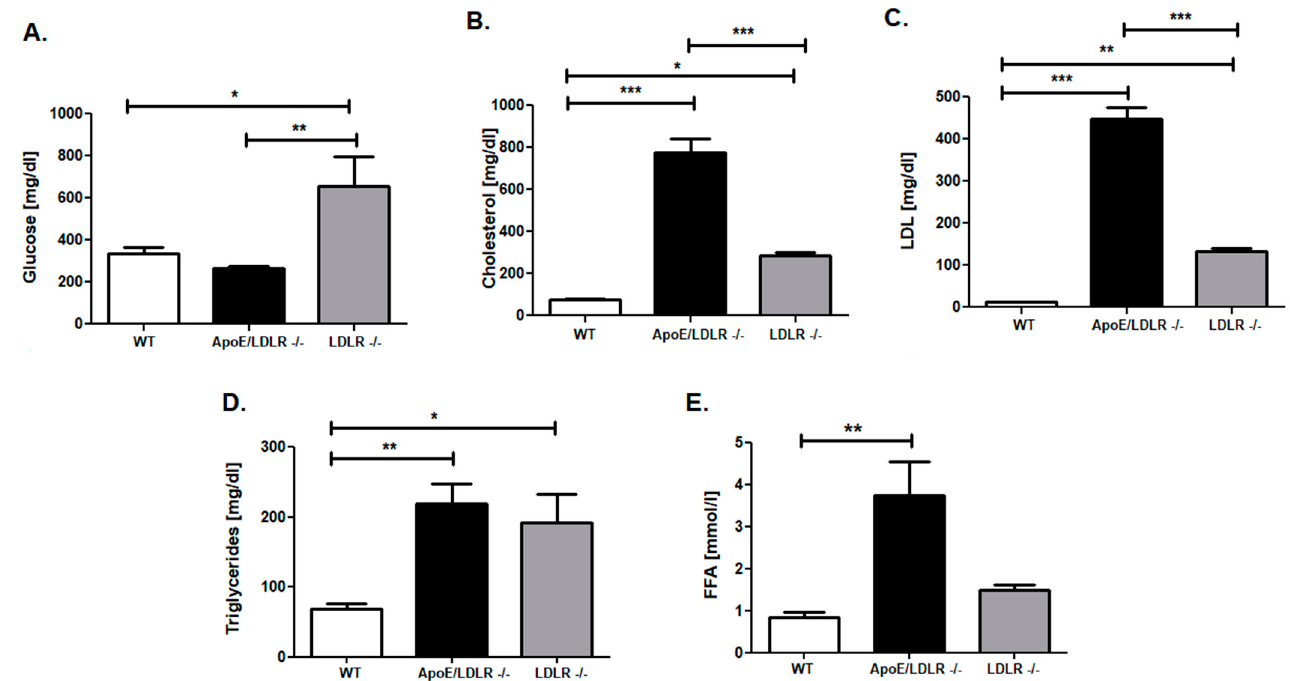
Figure 7. Profound alterations in blood lipid (ApoE/LDLR -/-) and glucose (LDLR -/-). Serum concentrations of glucose ( A ), cholesterol ( B ), LDL ( C ), triglycerides ( D ), and free fatty acid ( E ). Results presented as mean ± SEM, n = 6–8, * p < 0.05, ** p < 0.01, *** p < 0.001.